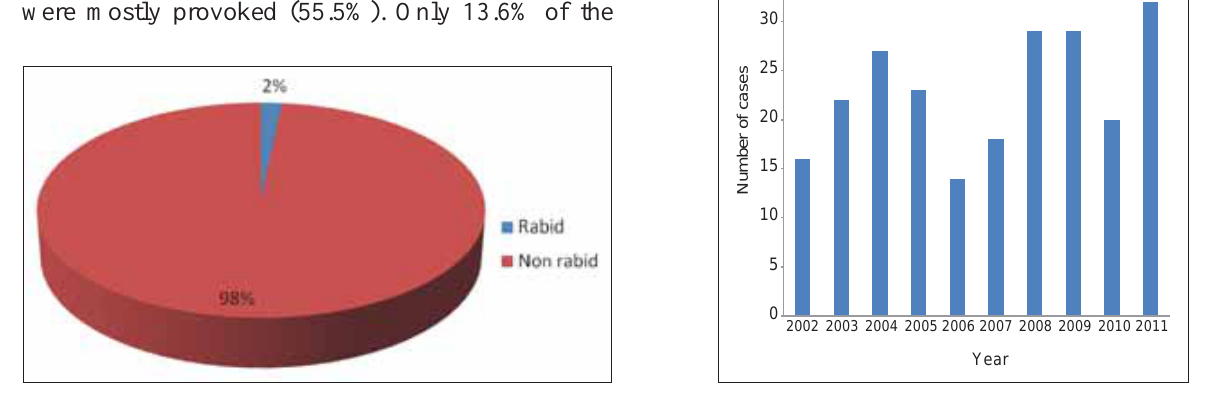
Figure-2: Annual incidence of dog bites presented to the VTH, Zaria between January 2002 and December